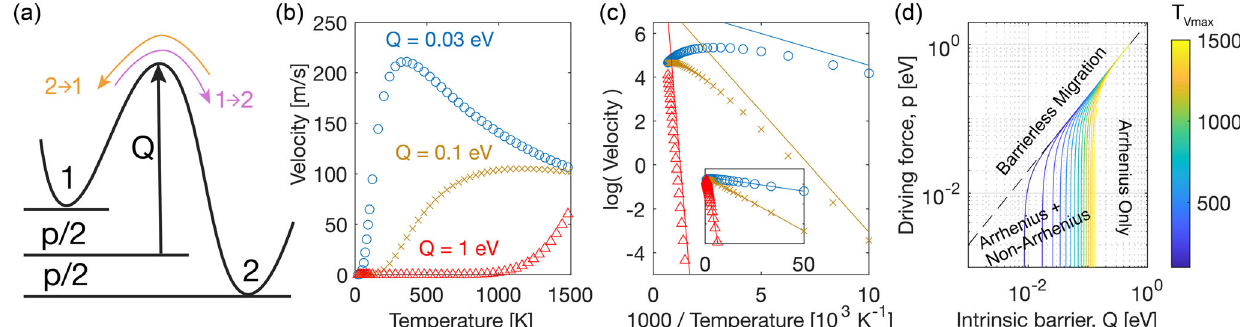
Fig. 1 Examination of classical model. a Potential energy landscape with intrinsic barrier Q and driving force bias p . b Plot of Eq. (3) for values of Q equal to 0.03, 0.1, and 1 eV. c Arrhenius plot (log( v ) vs. 1/ T ) of Eq. (3) overlaid with lines of velocity predictions based on traditional expectations following Eqs. (1) and (2). Note the large temperature range for the inset, which highlights the Arrhenius nature of curves with low values of Q at the very lowest temperature, but which obscures the non-Arrhenius nature of the same curves at high temperature, which is highlighted in the main plot. d Contour plot of Eq. (5) for different combinations of p and Q